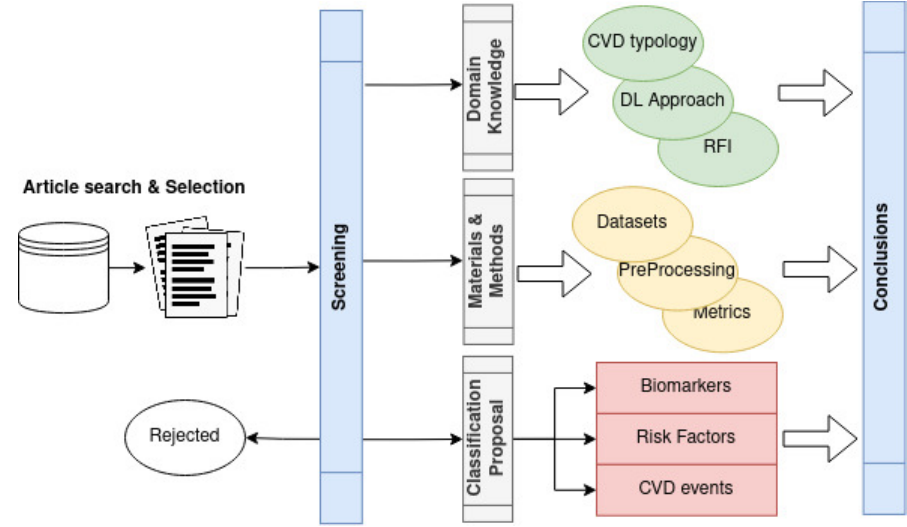
Figure 3. Proposed methodology